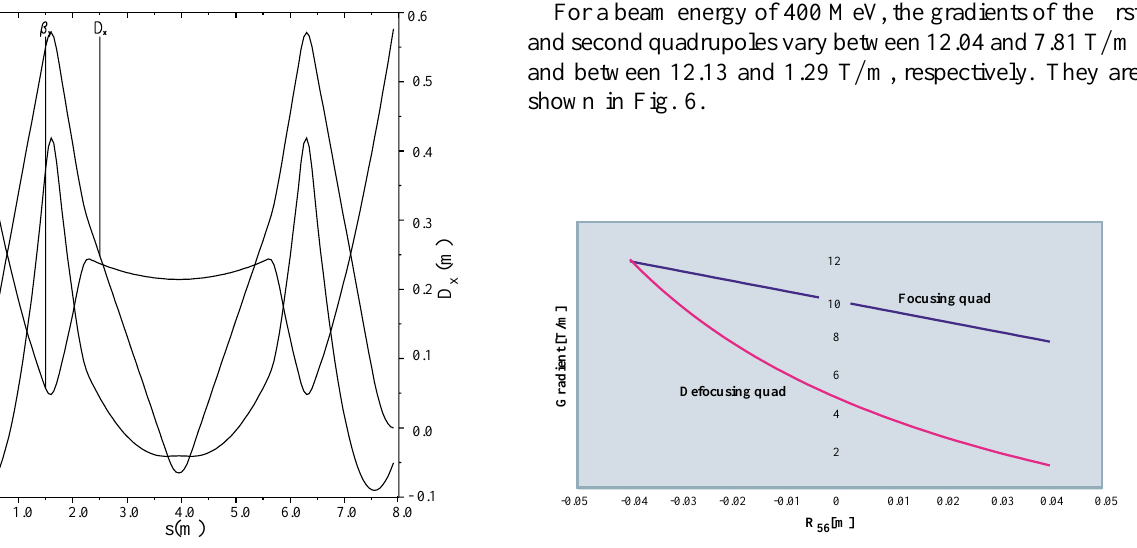
FIG. 6. (Color) Quadrupole gradients at 400